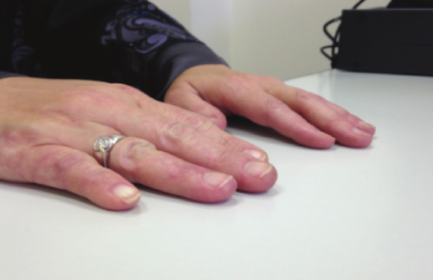
Figure 4: Following the second cycle of rituximab